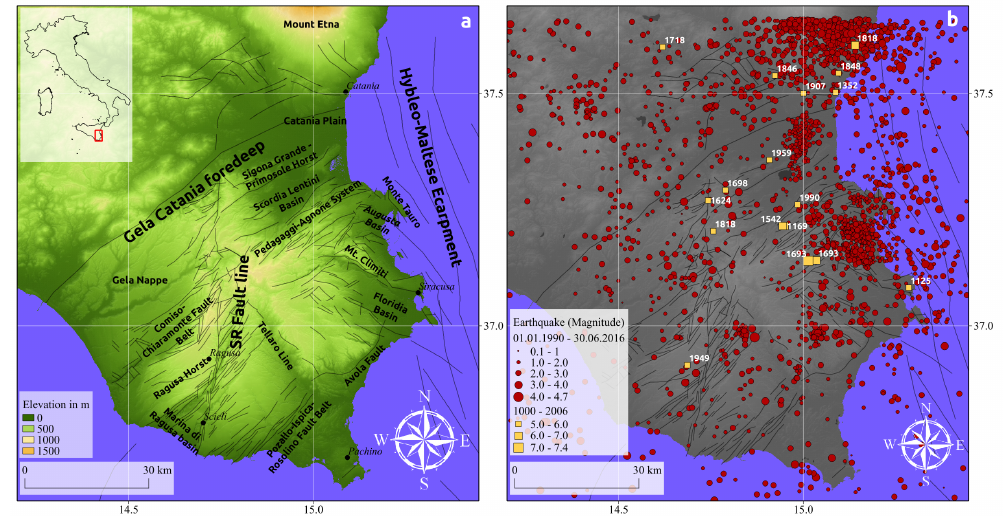
Figure 1. Location of the study area: ( a ) Topographic map of the study area with its toponomy (SR-Fault: Scicli-Ragusa fault); ( b ) Recent and historical earthquakes over the study area